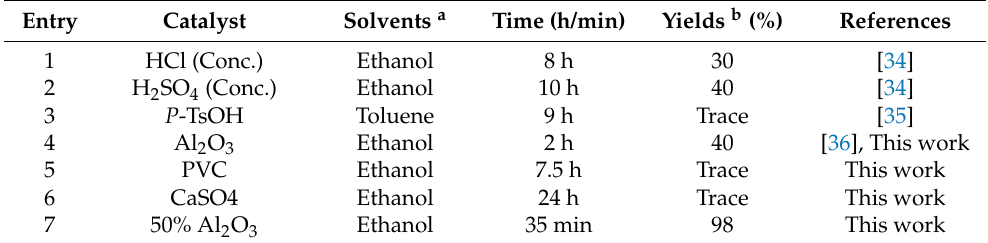
Table 5. Effects of different catalyst types on the synthesis duration and yield under solar